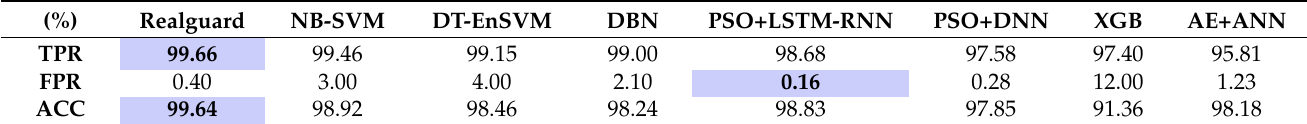
Figure 3. The experiment results of the binary-class attack detection. Table 4. Comparing binary detection performance between Realguard and its competitors.